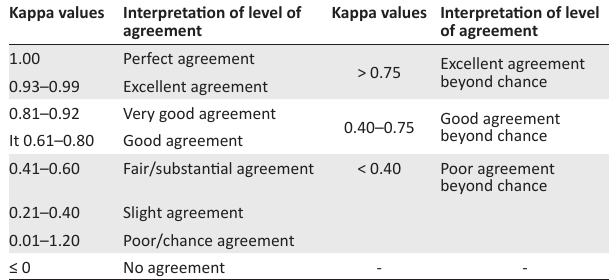
TABLE 2: Interpretation guidelines for kappa values for inter-rater